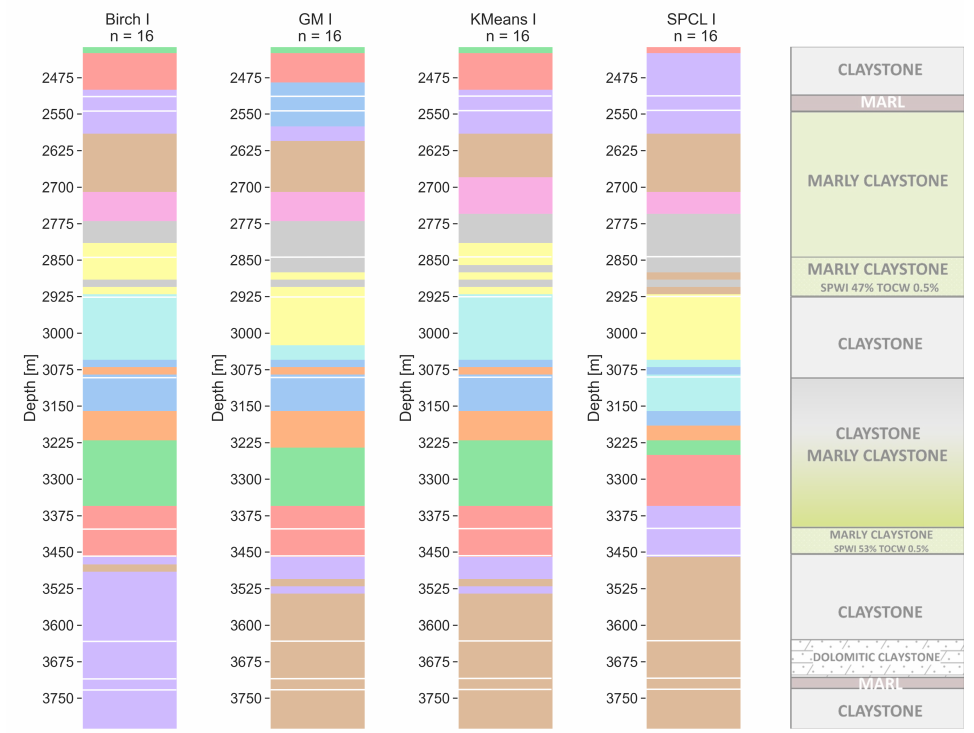
Figure 12. Walkaway VSP resolution clustering models for a number of clusters equal to 16 with lithology from well core (with lines). Clustering methods: BIRCH—balanced iterative reducing and clustering using hierarchies, GM—Gaussian mixture model, k-means, and SPCL—spectral